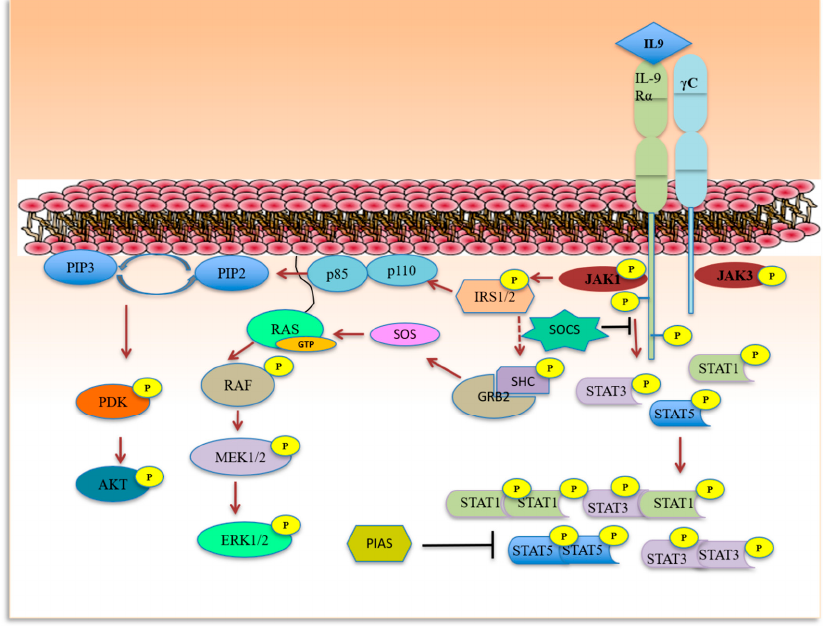
Figure 1. IL-9 mediated signal transduction. IL-9 binding results in the formation the IL-9R heterocomplex, which induces phosphorylation of JAKs. Phosphorylated JAKs then activate signaling intermediates of JAK-STAT, IRS—PI3 kinase, and MAPK pathways. (STAT—Signal Transducer and Activator of Transcription; IRS—insulin receptor substrate; MAPK—Mitogen-Activated Protein Kinase; PI3-K—Phosphatidylinositol-3 Kinase having two subunits, p110 and p85; PDK—PI3-K dependent kinase; PIAS—Protein Inhibitors of Activated STATs; SOCS—Suppressors Of Cytokine Signaling).